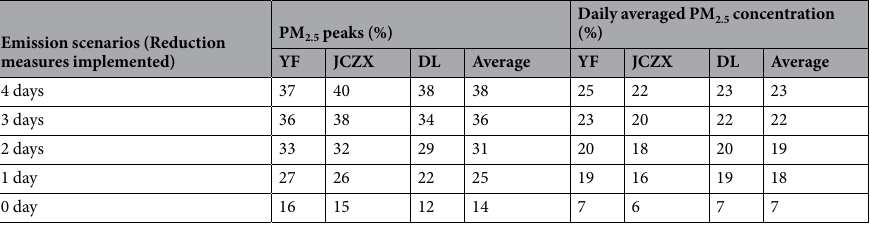
Table 3. Effects of implementing emission reduction measures of four, three, two, one and zero days before the start of red alerts on the reduction of PM 2.5